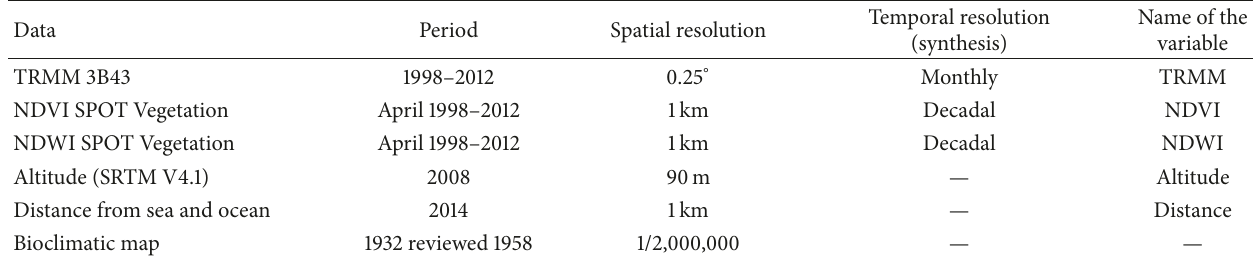
Table 1: Datasets used in this